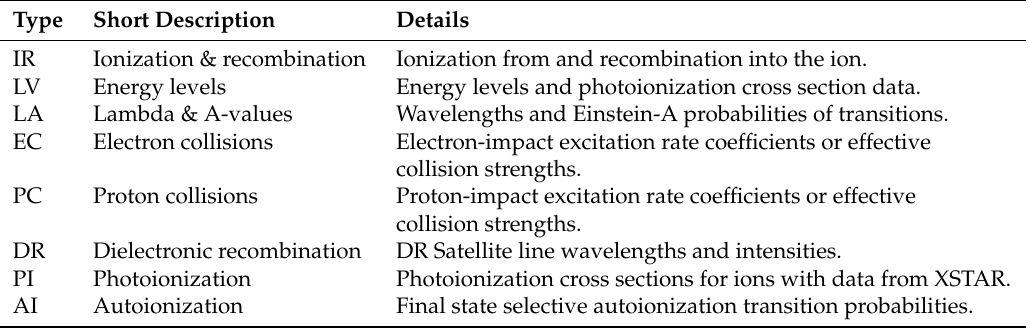
Table 1. File types for per-ion atomic data in the Astrophysical Plasma Emission Database (APED).